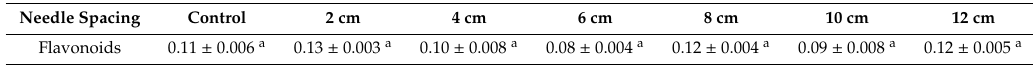
Table 4. Flavonoid content (g / 100 g) under di ff erent needle